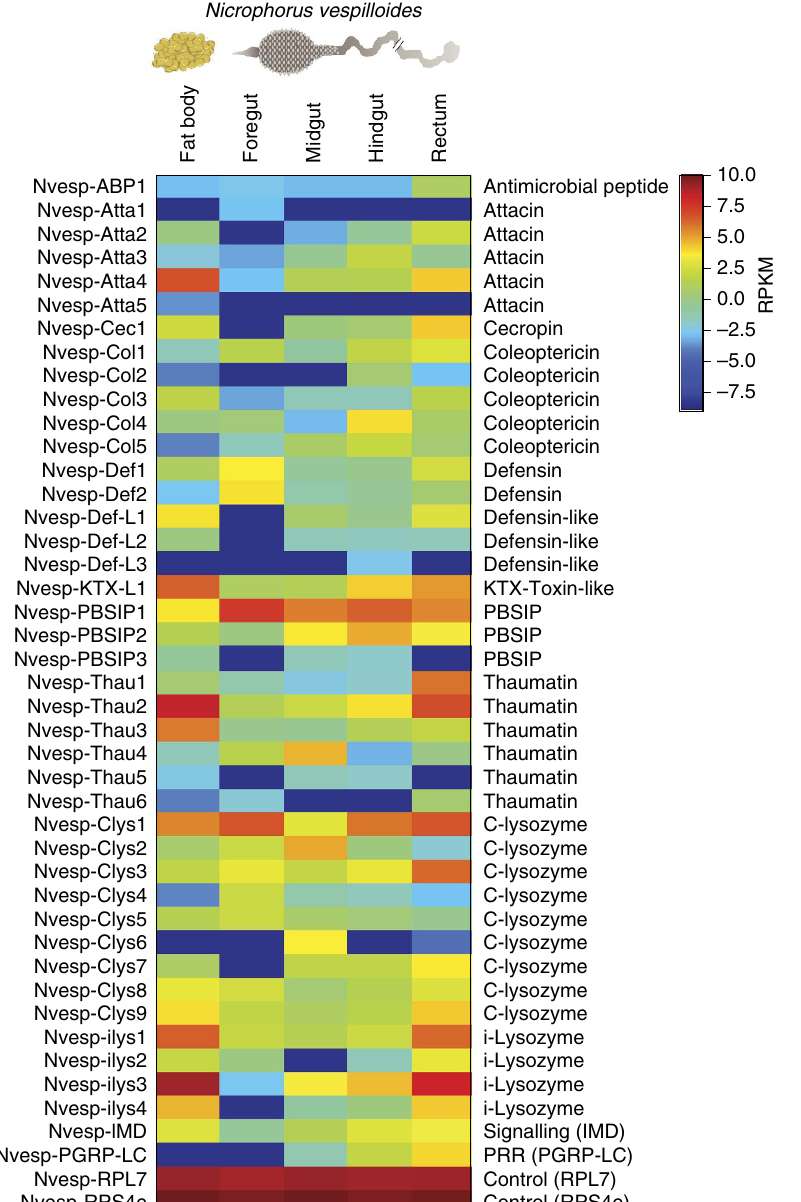
Figure 2 | Relative gene expression levels of AMPs and lysozymes in N. vespilloides tissues. Different gut regions and the fat body of pooled N. vespilloides males and females were analysed. The housekeeping genes RPL7 and RPS4e were used as controls to verify consistent expression patterns in the different tissues. Log2-transformed RPKM values are plotted, with warmer colours representing higher relative gene expression